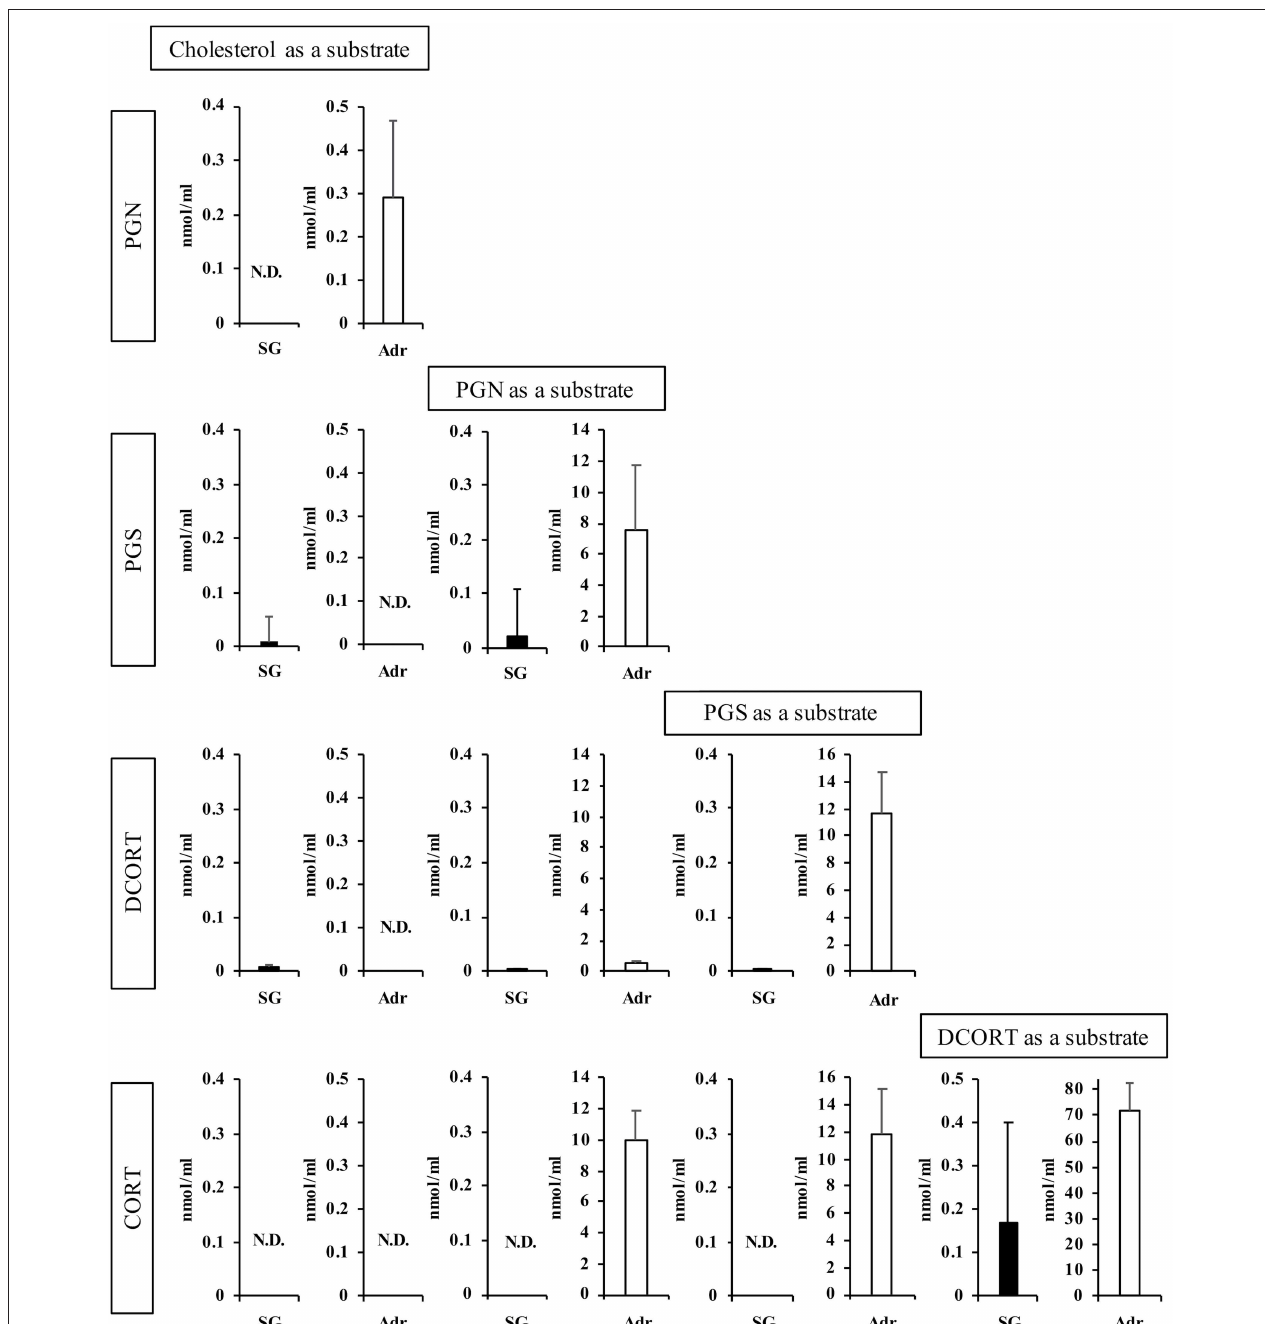
FIGURE 3 | Enzymatic activities associated with steroidogenesis in rat salivary gland (SG) and adrenal gland (Adr). The concentrations of pregnenolone (PGN), progesterone (PGS), deoxycorticosterone (DCORT), and corticosterone (CORT) produced from each substrate (cholesterol, PGN, PGS, and DCORT) were determined after a 2-h enzymatic reaction using rat SG ( n = 3, closed bars) and Adr ( n = 3, open bars) homogenates and LC-MS analysis. Data are shown as the mean ± S.D.